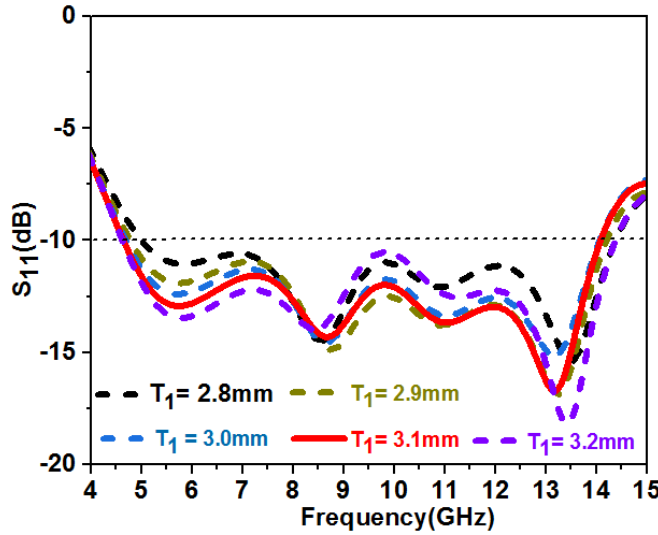
Figure 9. Parametric analysis for variation in T1 for S 11 .